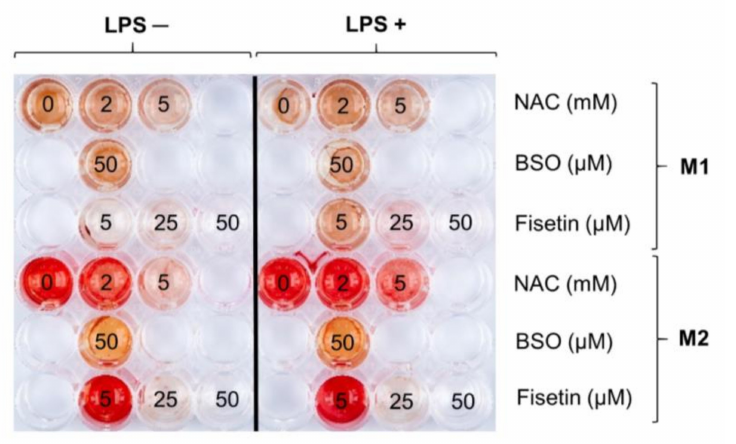
Figure 4. Mineralization occurrence in human pulp cells after 21 days in the various experimental conditions. Images of cell cultures in situ after staining with Alizarin red. M1 = complete growth medium; M2 = complete growth medium with dexamethasone and β -glycerophosphate. Numbers indicate concentrations of NAC, BSO or fisetin (in mM or µ M). Mineralization in human pulp cells is downregulated in the presence of the prooxidant BSO and the antioxidants NAC and